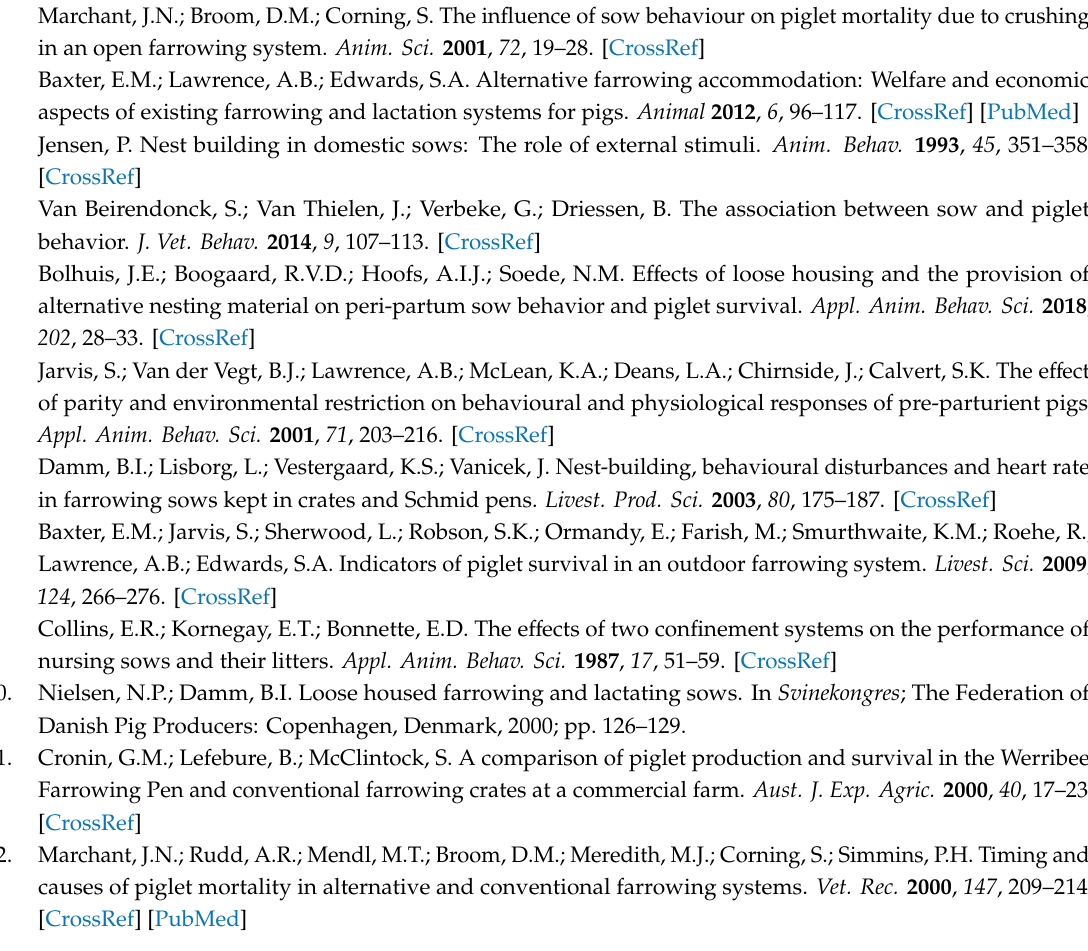
Table S1: The piglet production and loss of sows in di ff erent farrowing systems (farrowing crate, FC; free farrowing pen with sloping walls, FFS; free farrowing pen with sloping walls and nest materials, FFSN). Author Contributions: Conceptualization, X.G., X.Z. and Y.H.; Performed the experiments, X.Z.; Data